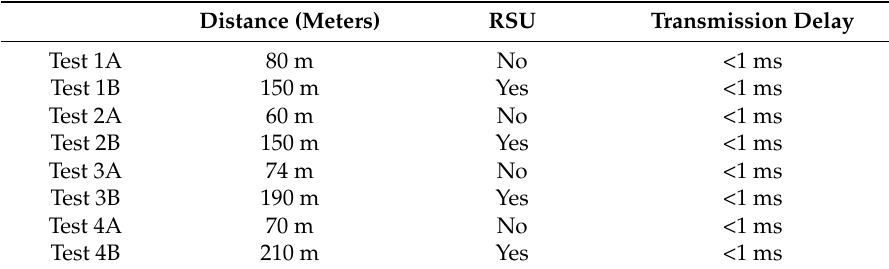
Table 2. Comparison among the different ranges of the system in the tests.